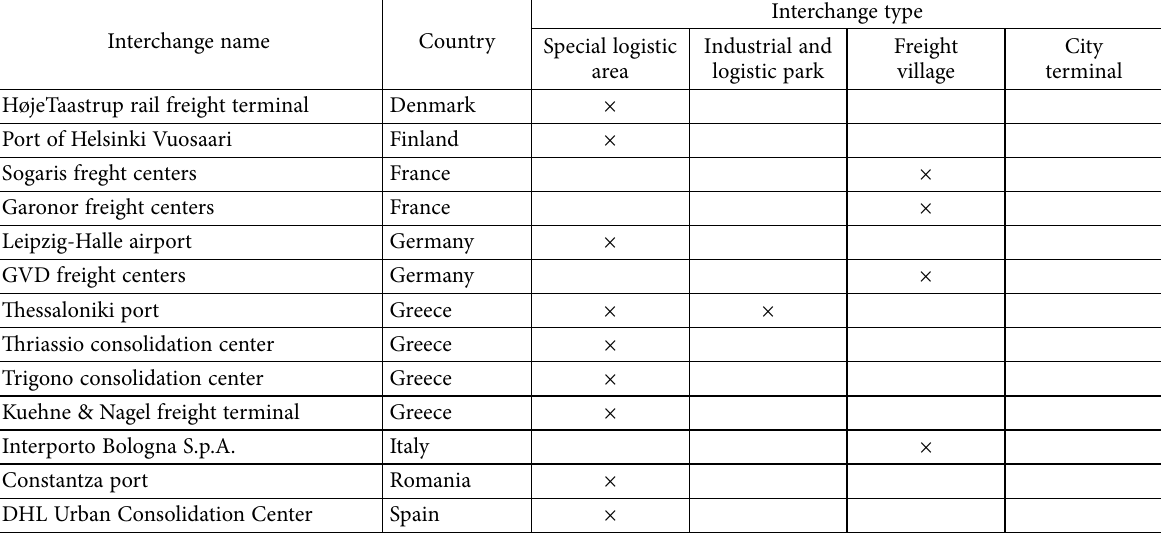
Table 3. Overview of freight interchanges in European